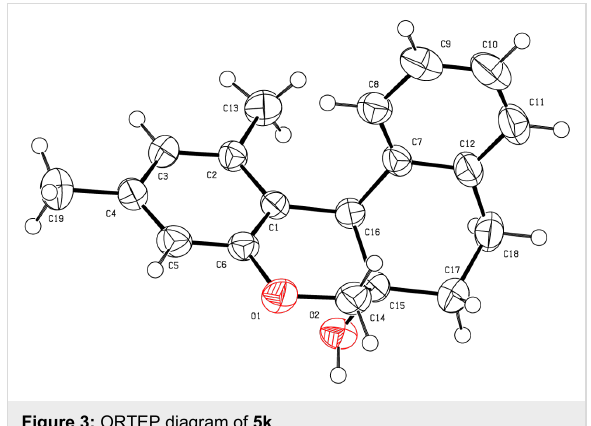
Figure 3: ORTEP diagram of 5k